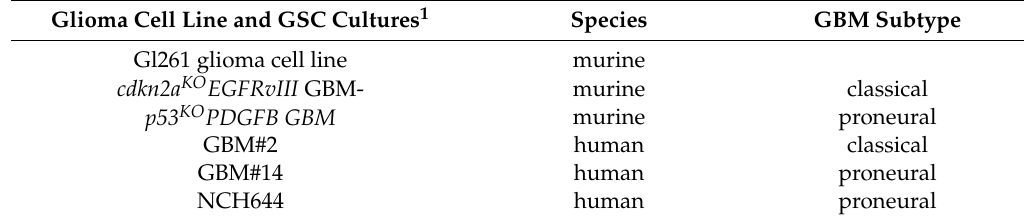
Table A1. Glioblastoma stem-like cell (GSC) cultures.